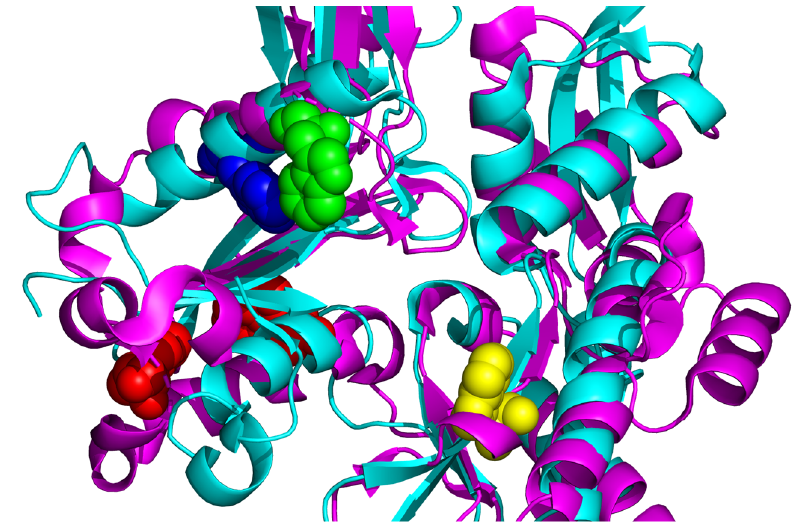
Figure 9. Localization of tryptophan residues in Tm-MreB and skeletal alpha-actin. Monomeric rabbit skeletal alpha actin (PDB: 1NWK) is in magenta; Tm ‐ MreB (PDB: 1JCG) is in blue. The Trp ‐ 79 tryptophan residue of actin can be seen as green spheres; it is the most accessible for the solvent compared with the other three tryptophan residues of actin. The Trp ‐ 86 of actin, which is mostly quenched by cysteine and methionine residues, is in blue, and the most intrinsic residues are in red. The position of single tryptophan of Tm ‐ MreB is in yellow; it is positioning separately from the tryptophan residues of actin. It does not seem as accessible to solvent as Trp ‐ 79 of actin, but it is in the cleft between two subdomains; therefore, it can be sensitive for conformational changes.